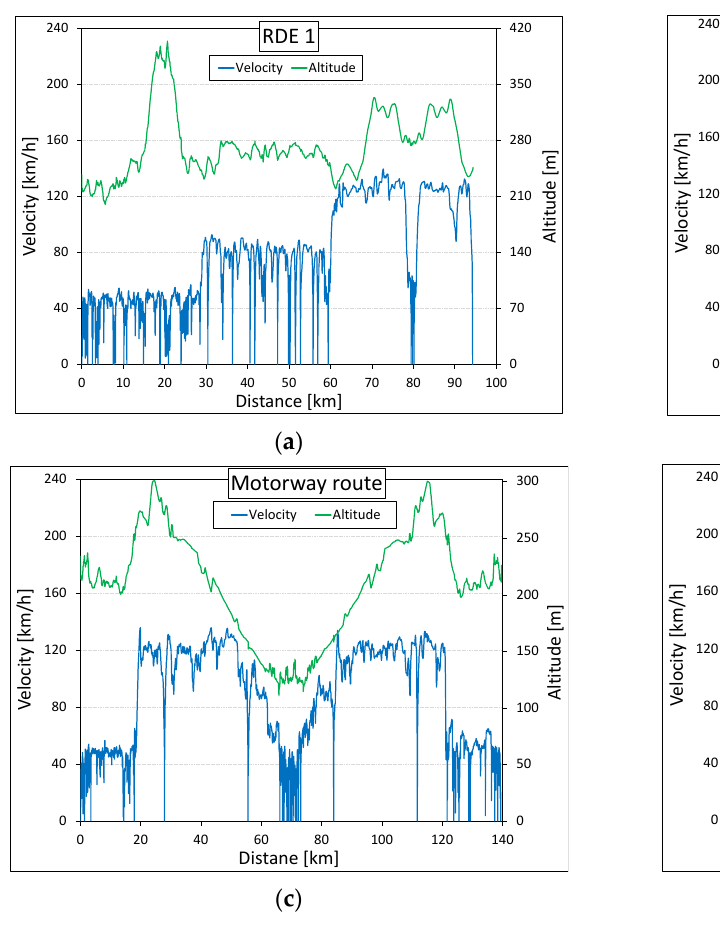
Figure 1. Velocity and altitude profiles on the routes followed during on-road testing. ( a ) RDE 1 route, ( b ) RDE 2 route, ( c ) motorway route, ( d ) hilly route.